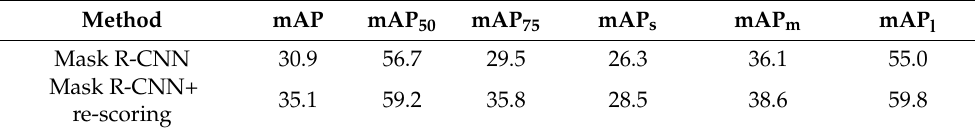
Table 5. Using different methods for instance